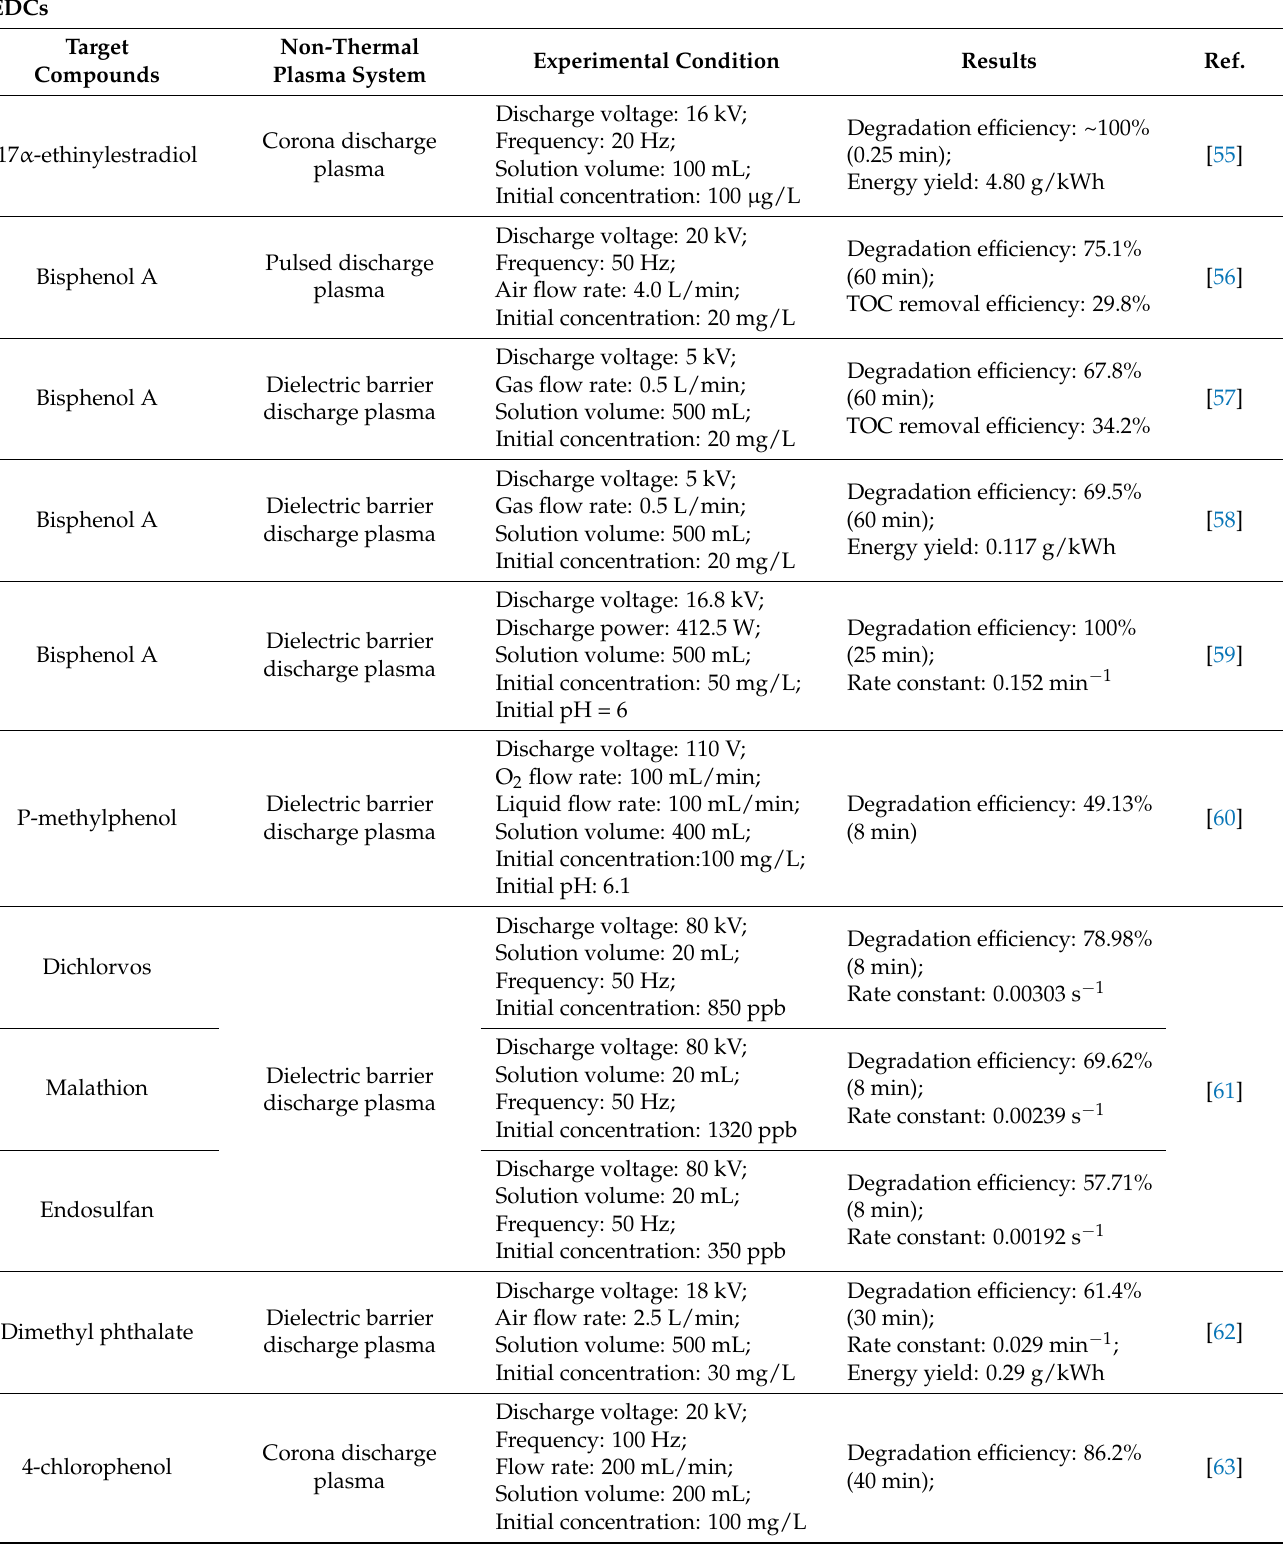
Table 1. Overview of work done in the degradation of EOPs in water by non-thermal